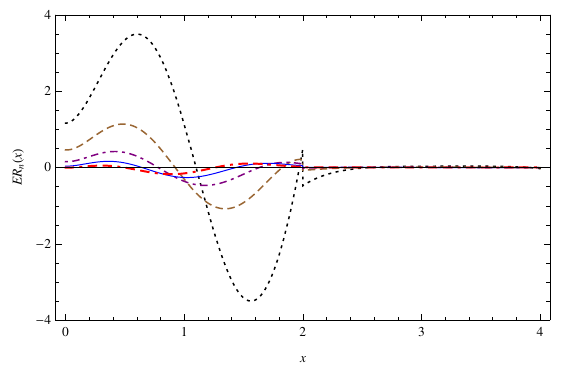
Figure 11: Curves of the error remainder functions ER n ( x ) for n = 3 (dot line), n = 4 (dashed line), n = 5 (dot-side line), n = 6 (solid line), and n = 7 (dot-side-side line).